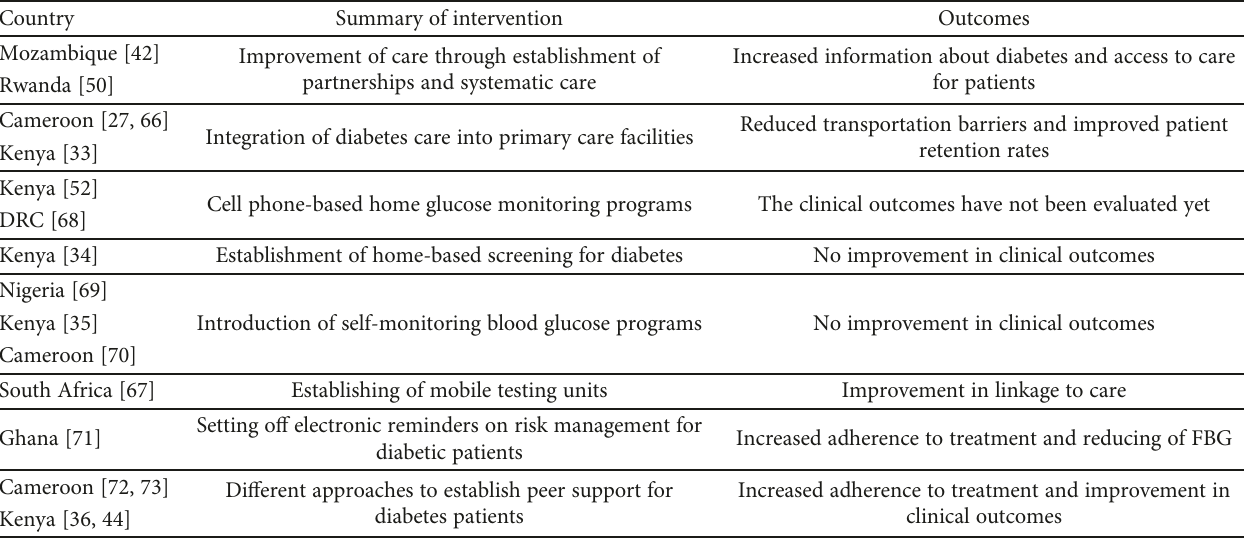
Table 1: Examples of interventions to improve patient adherence to diabetes treatment in